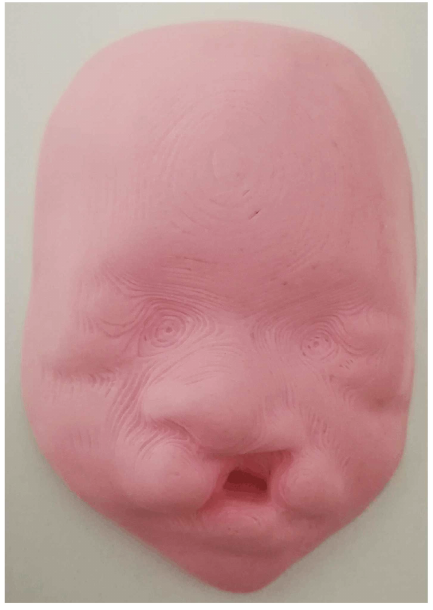
Figure 7: 3D model of a 30-week-old fetus a ff ected by a cleft lip pathology. Table 2: Sociodemographic information of the parents ’ sample.